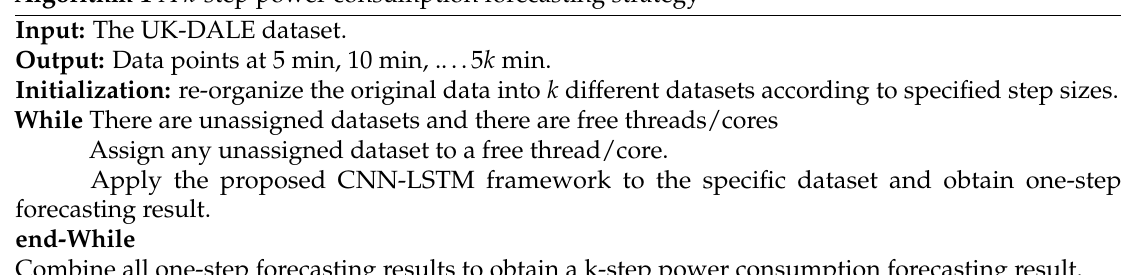
Algorithm 1 A k -step power consumption forecasting